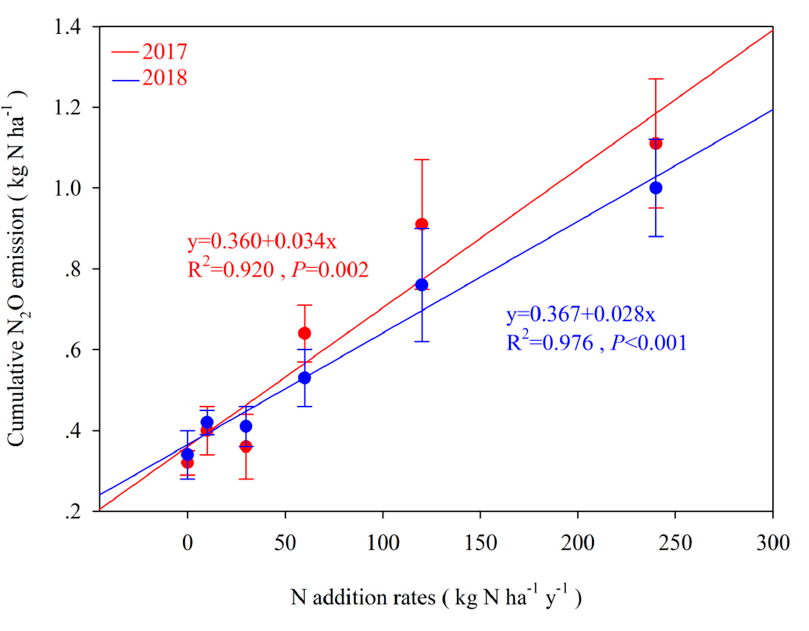
Figure 3. Relationship between cumulative N 2 O emissions and N addition rates over the 2017 and 2018 growing seasons ( n = 6). Mean ± standard error ( n = 4) is presented. Table 1. Cumulative N 2 O emissions ( Ʃ N 2 O) and applied ‐ N scaled emission factors (EF) as affected by N addition treatments in 2017 and 2018 growing seasons. Treatment